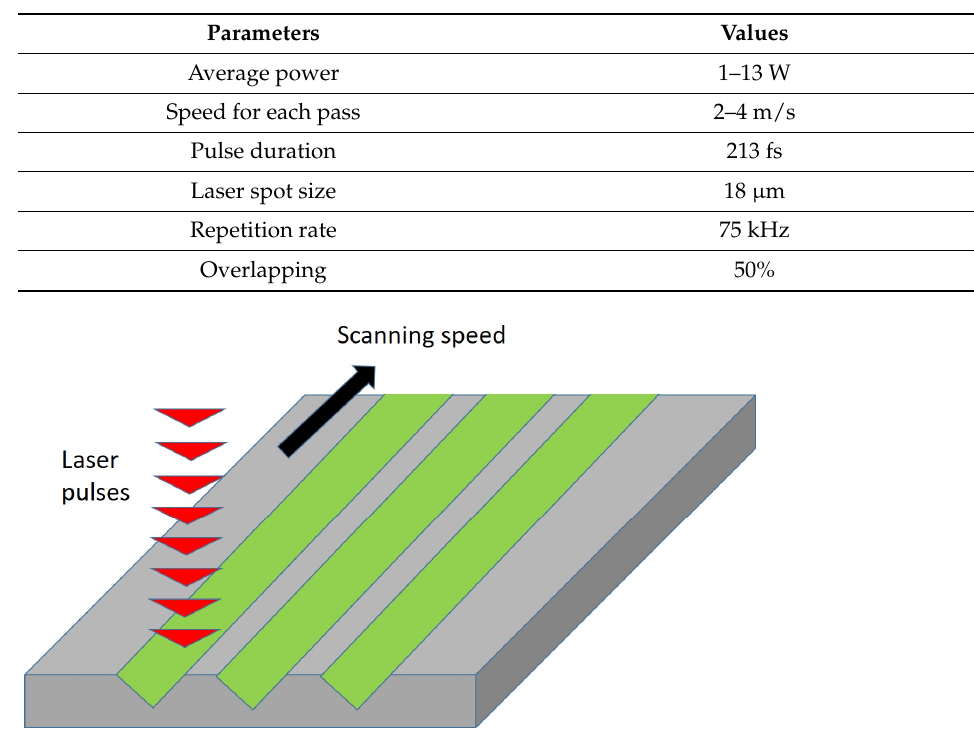
Figure 1. Schematic representation of the laser texturing